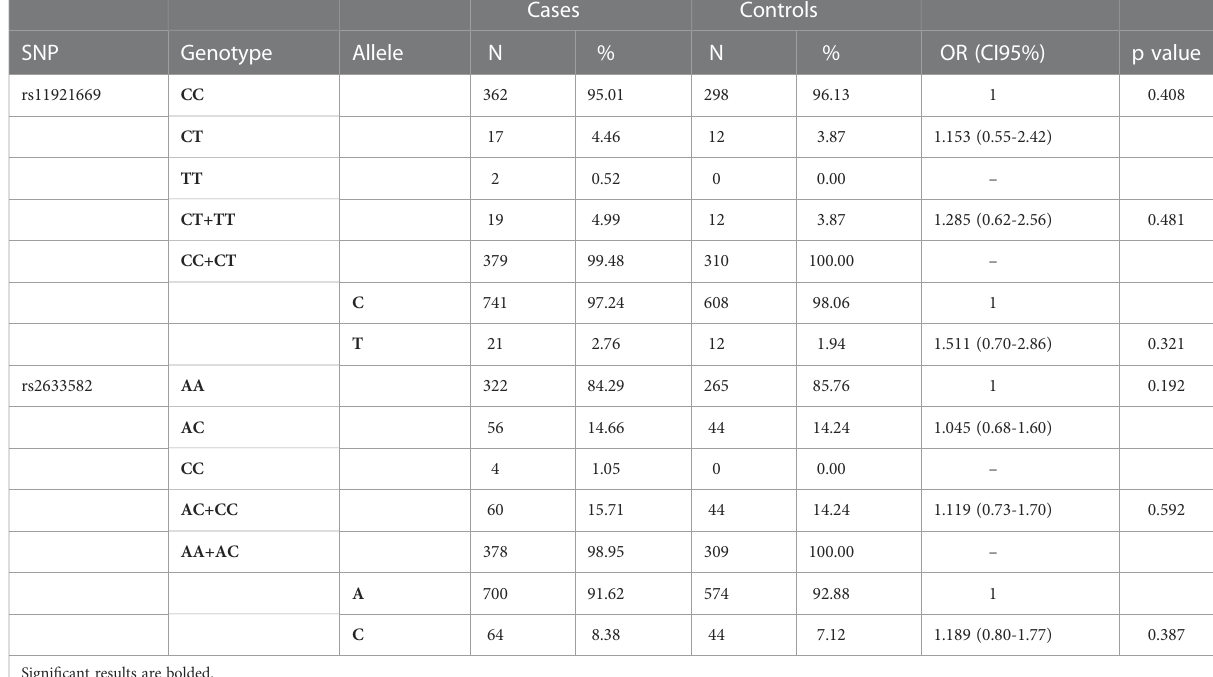
Table 4). When comparing haplotype frequencies between smoking and never-smoking patients we observed a similar pattern of haplotype distribution as between controls and never- smoking patients (Figure 2).